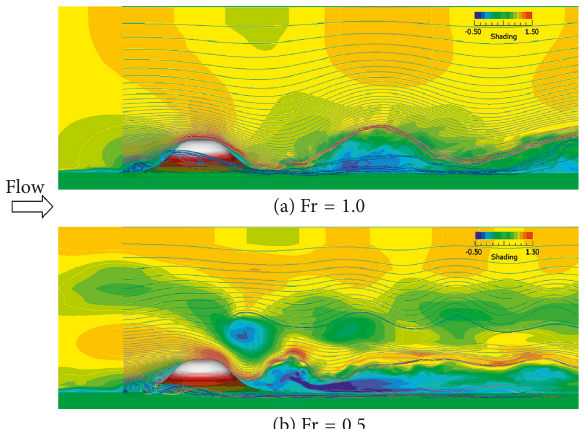
Figure 15: Result of visualization by computational simulation of wind conditions, Re � 10 4